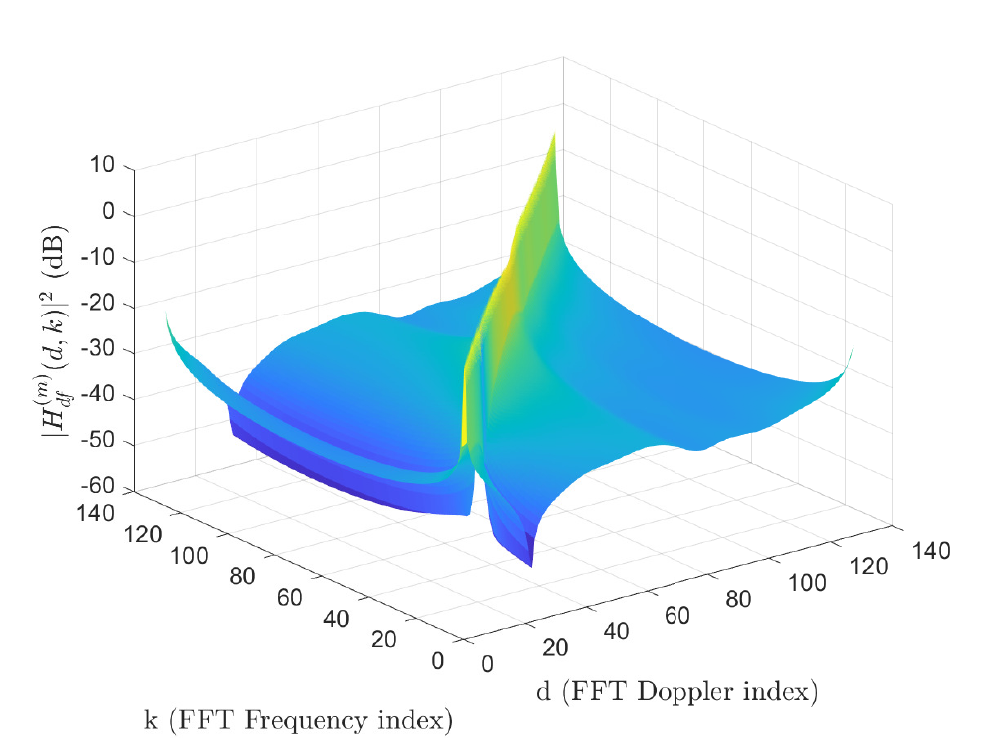
Figure 3. Ideal coupling matrix for a ITU Vehicular A channel model with v = 500 km/h at a carrier frequency of 2 GHz using FFTs of 128 points and 15 kHz of sub-carrier